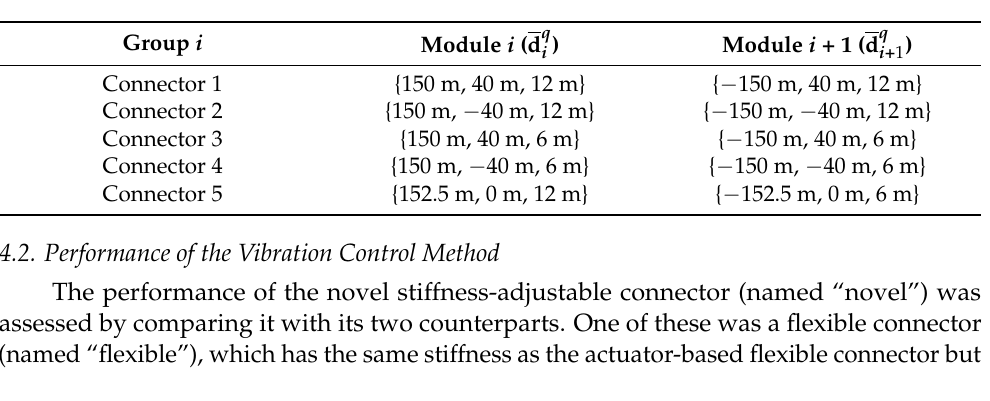
Table 2. Local coordinates of the novel